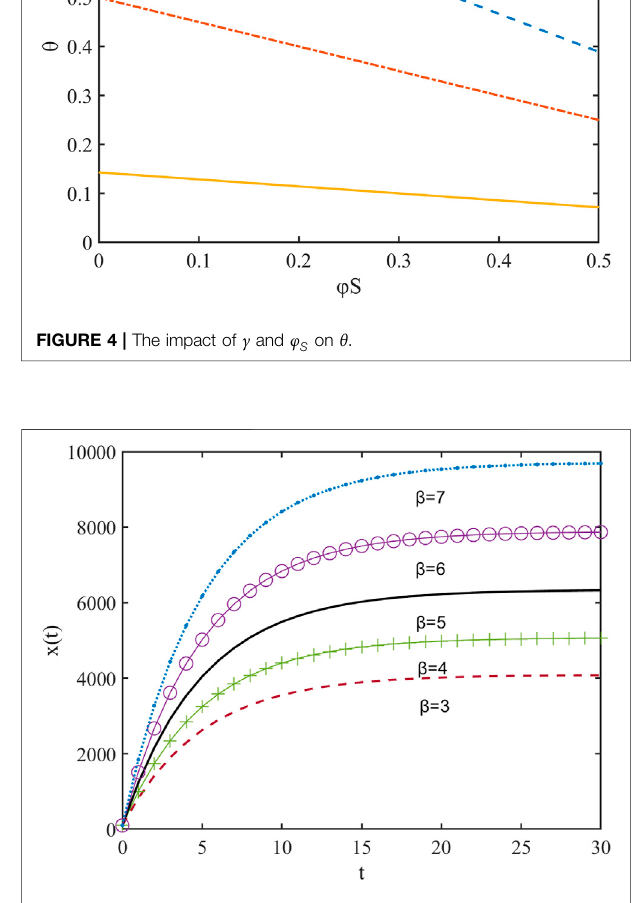
FIGURE 5 | The impact of β on x ( t ) .